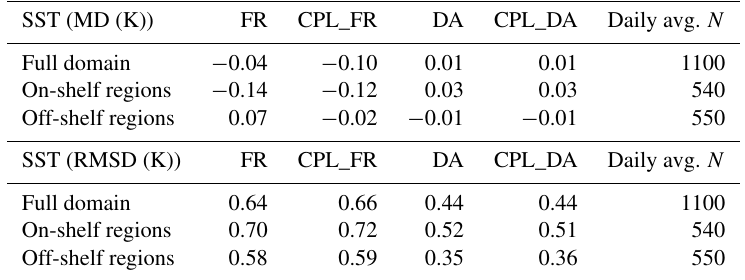
Figure 1. Seasonal mean of wave model simulated (a, d) significant wave height, (b, e) fraction of ocean to atmosphere surface stress, and (c, f) Stokes drift speed during (a–c) winter 2016/2017 and (d–f) summer 2017. Table 2. SST mean difference (MD = Model minus Observation), and root-mean-square difference (RMSD) statistics computed over 2-year period (2016–2017) comparing each simulation experiment with available in situ observations. The daily average number of observations ( N ) used for each comparison is also